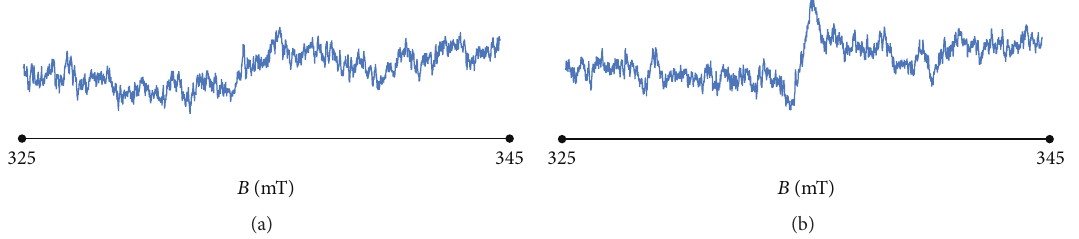
Figure 2: EPR spectra of (a) salicylic acid and (b) urea after UV irradiation for 60 minutes. Microwave power was 2.2 mW. 𝐵 is the magnetic induction of the field produced by electromagnet of the EPR spectrometer.